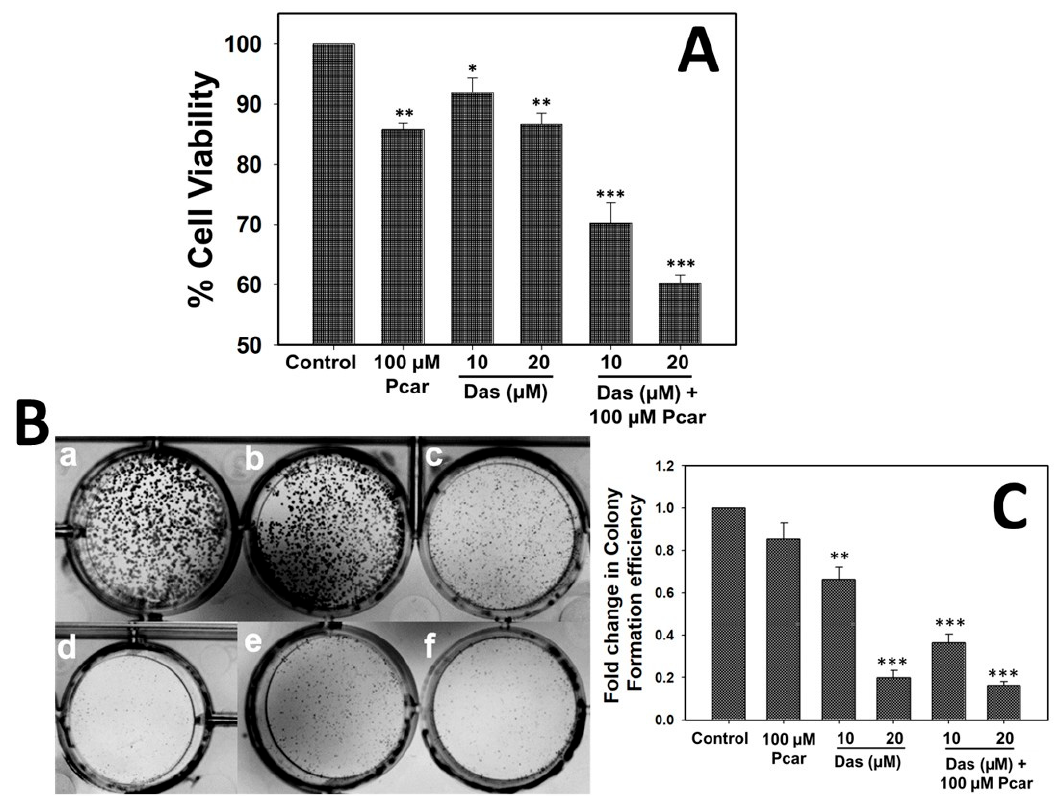
Figure 1. Pcar and Das combined treatment induces more toxicity and inhibits colony formation efficiency in HepG2 cells. ( A ) MTT assay showing that combined treatment of Pcar and Das acts synergistically and reduces the cell viability. ( B ) Colony formation efficiency showing less colony formation in the combination treatment group (e and f) than in single-treatment groups (c and d) and control group (a). ( a ) Control; ( b ) 100 µM Pcar; ( c , d ) 10 and 20 µM Das; ( e , f ) 100 µM Pcar + 10 and 20 µM Das. ( C ) Quantitative estimation of colony formation efficiency of treated and control cells. Data expressed as mean ± standard error (SE) calculated from three ( n = 3) independent experiments, * p < 0.05, ** p < 0.01, *** p < 0.001. Statistical significance has been calculated by comparing the treated cells (only Pcar, only Das, and Pcar+Das) in reference to control cells in each group.